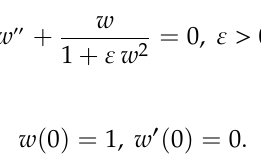
Figure 7. The corresponding absolute errors to approximate solutions using the modified decomposition method (red solid line) and RK4 method (blue line) for 0 ≤ t ≤ 30 and step-size h = 0.5.